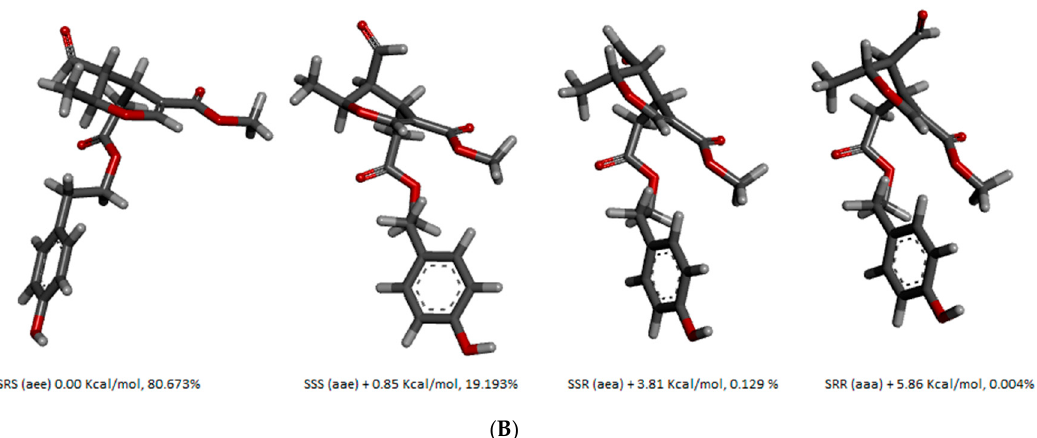
Figure 5. ( A ) 1 HNMR spectra of the two diastereoisomers (5 S ,8 R ,9 S )- 7 and (5 S ,8 S ,9 S )- 7 . ( B ) Density functional theory (DFT)-optimised conformations of the four diastereoisomers of compound 7 , reporting the absolute configurations (axial/equatorial position of the side chains), relative energies and percentage of the population at room temperature.